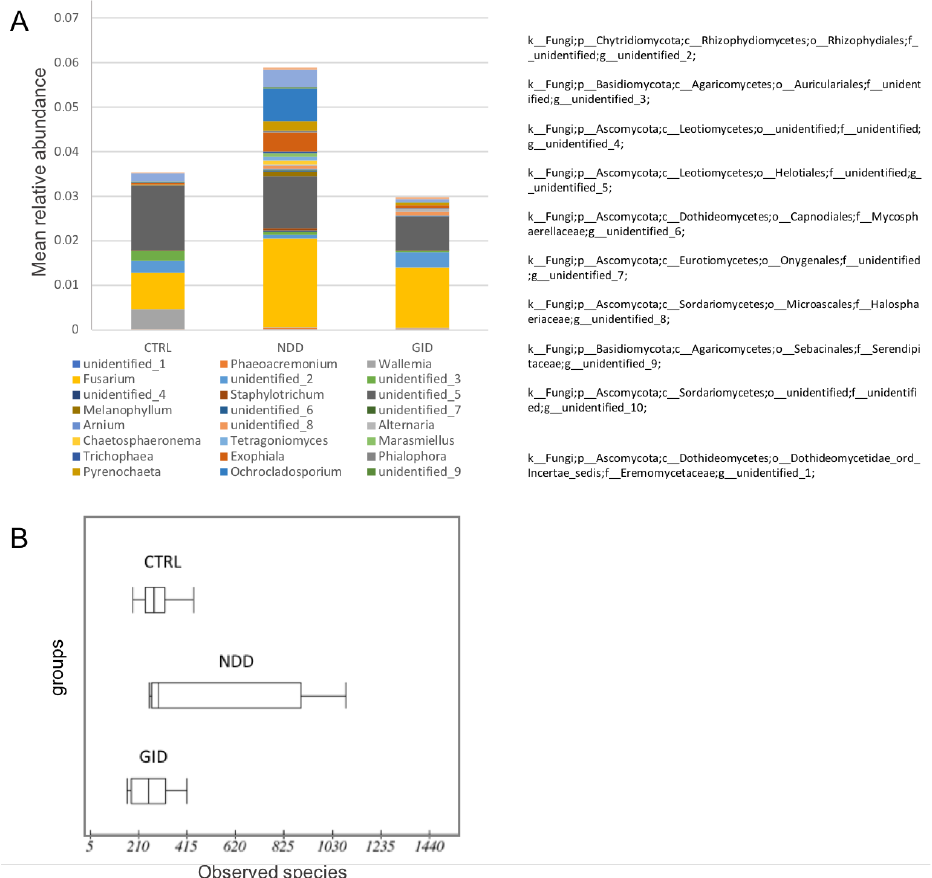
Figure 3. Fungal alpha diversity in CTRL, NDD and GID. Mean relative abundances of 14 most significant fungal genera and the higher taxonomic classification of the unidentified genera ( A ); alpha diversity by the number of observed species ( B ).